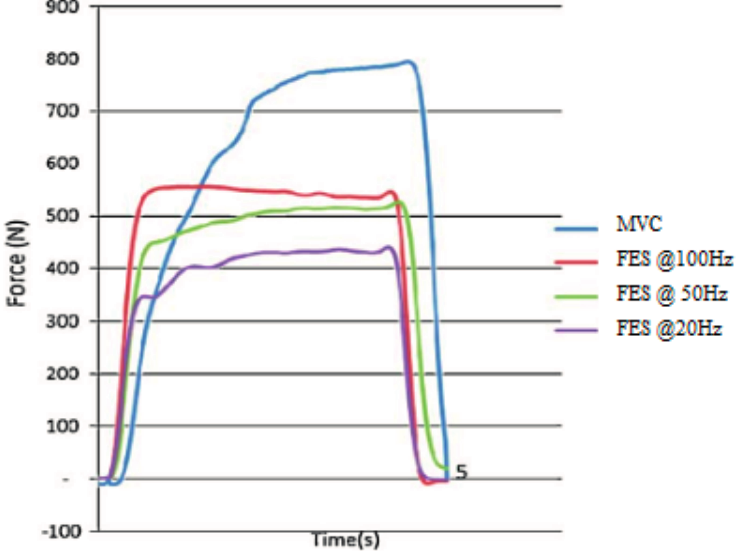
Figure 3. Quadriceps femoris muscle force under maximum voluntary contraction (MVC) and electrically evoked contraction (FES) at 100 Hz, 50 Hz and 20 Hz stimulation frequency [73]. The graph shows that the force generated against time in electrically evoked contraction depends on the stimulation